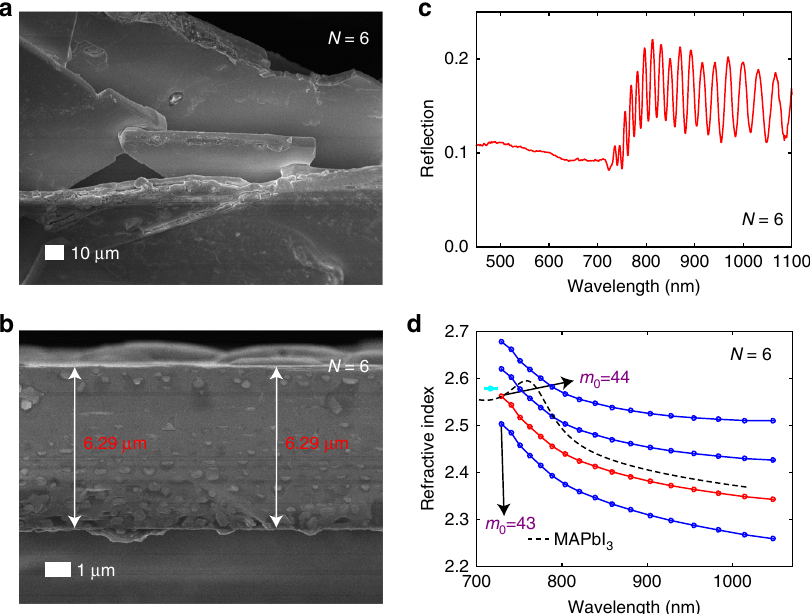
Fig. 3 Determination of the refractive index for N = 6. a Angular and b side-view of the examined fl ake taken under SEM. c Re fl ection spectrum and d several possible n ′ ( λ ) curves obtained using different m 0 values, with the correct n ′ ( λ ) curve shown in red. The cyan dot denotes the refractive index at the absorption onset wavelength determined from a separate